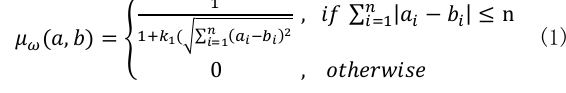
Figure 1. Framework of our